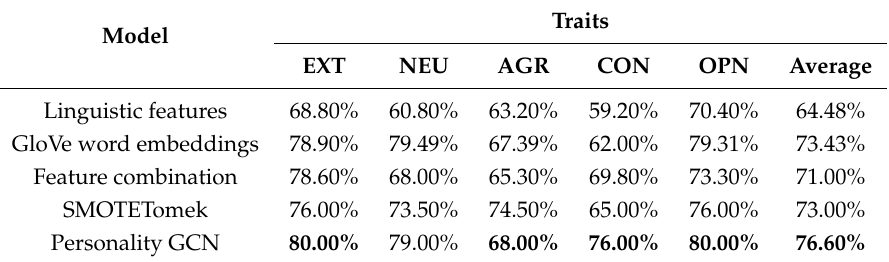
Table 4. Personality GCN classification results of accuracy on the myPersonality